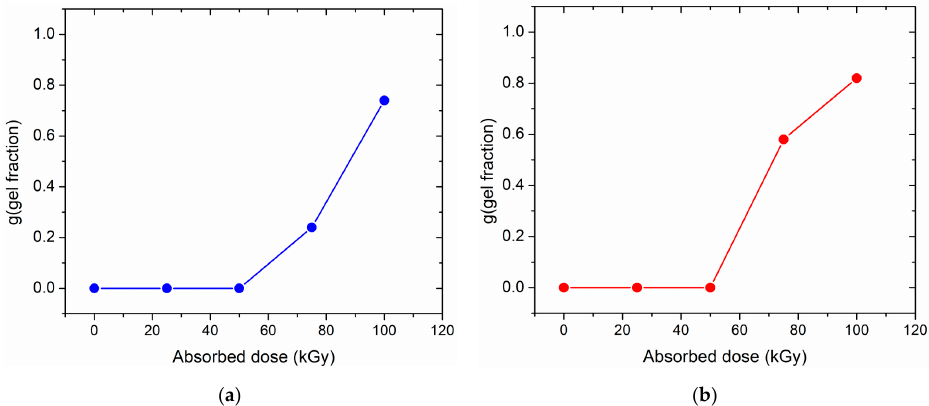
Figure 4. ( a ) Estimated gel fractions of HDPE as a function of absorbed dose for samples irradiated with electron beam and ( b ) gamma rays.